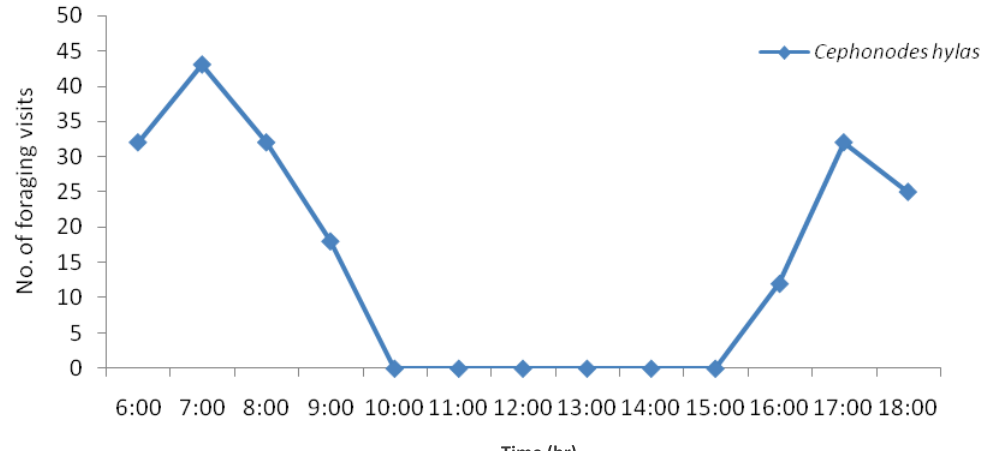
Figure 7. Hourly foraging activity of hawk moth on Syzygium alternifolium